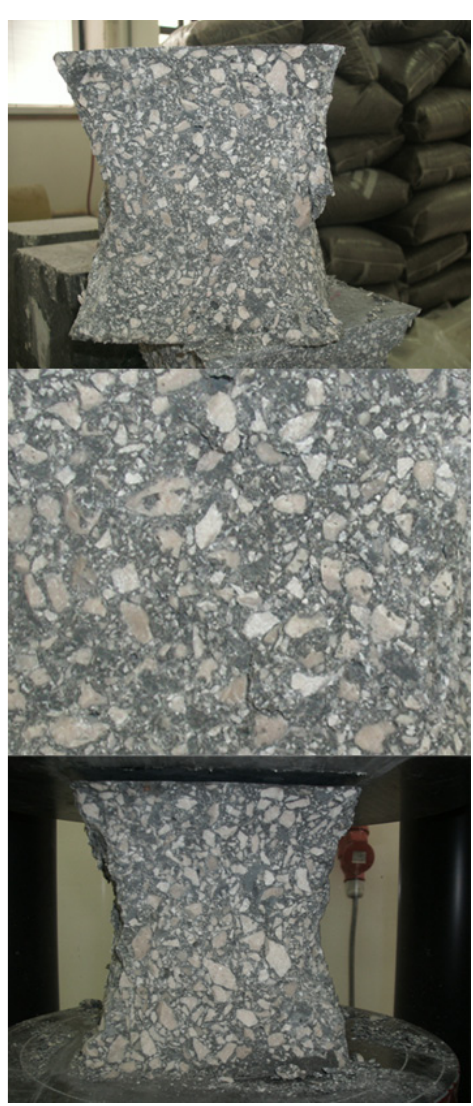
Figure 12. ESCC, MSCC and VSCC specimens after compressive strength